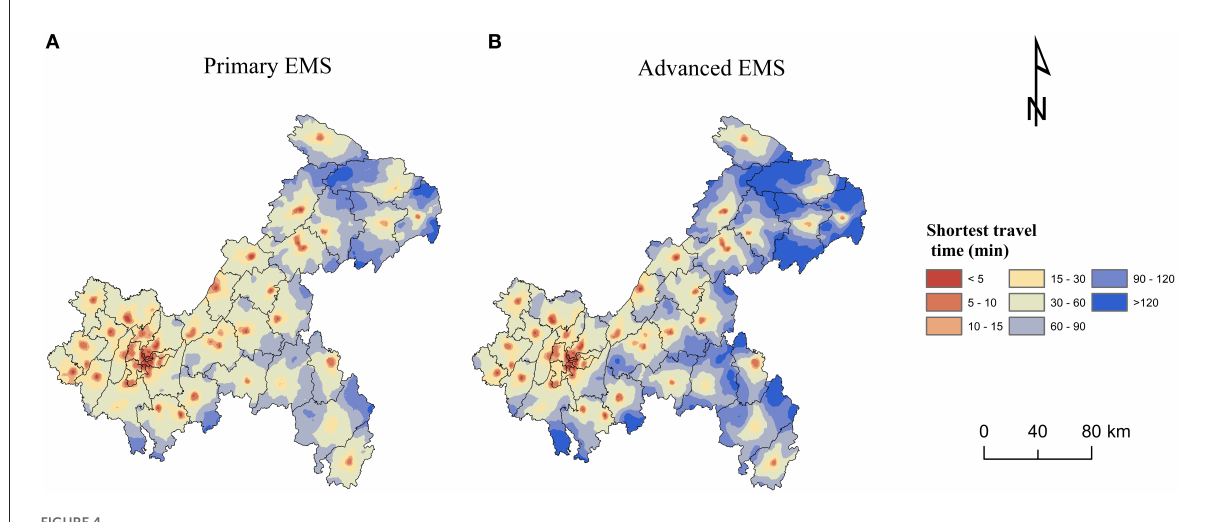
TABLE 6 Distribution of the shortest ravel time to get advanced emergency medical services (EMS). Shortest travel Percentage of covered population (communities/villages) at different shortest time (min)